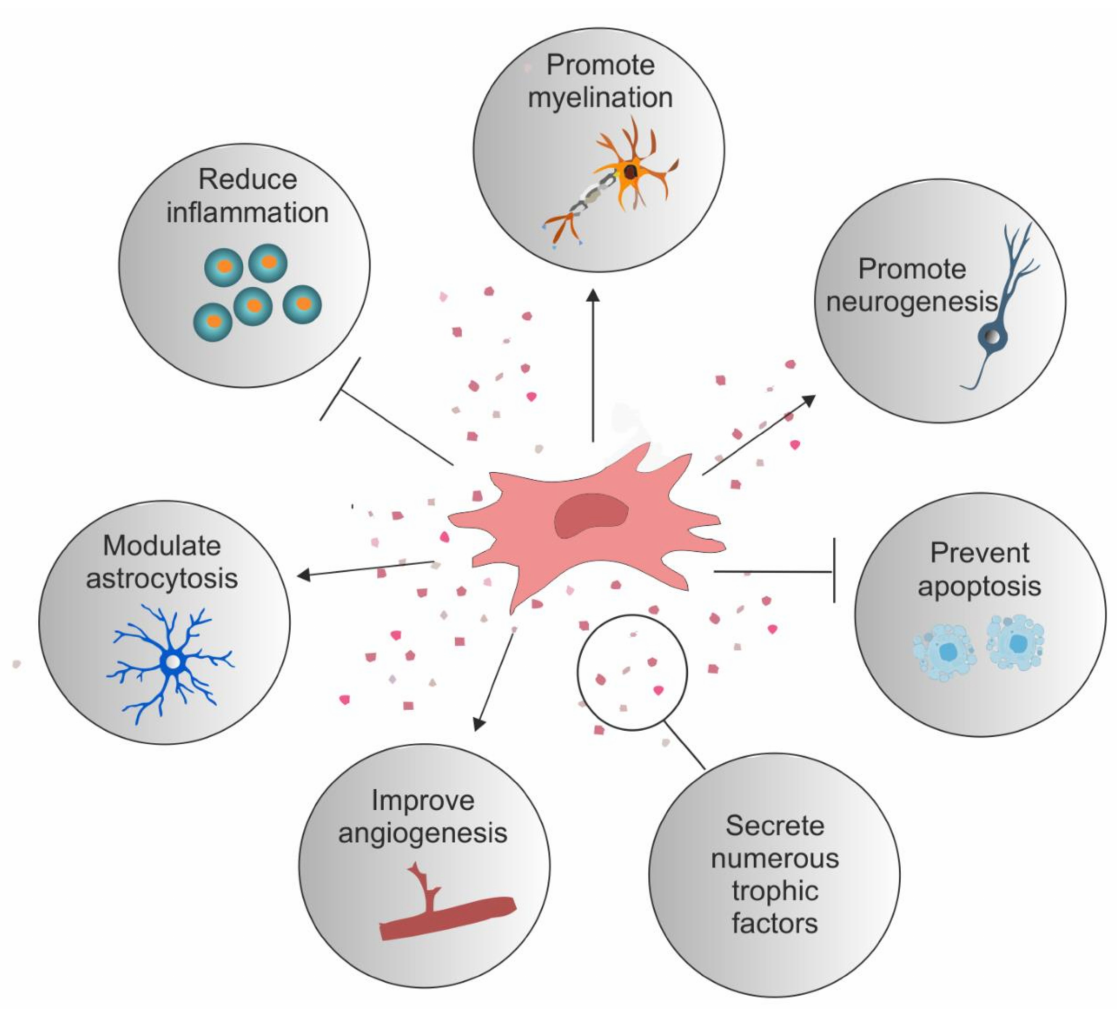
Figure 1. Reparative role of mesenchymal stromal cells. Examples of the reparative potential of mesenchymal stromal cells (MSCs) for spinal cord injury (SCI). MSCs secrete numerous trophic factors and anti-inflammatory molecules that change the injury milieu to pro-regenerative. These secreted factors have an anti-inflammatory effect on numerous immune cells such as T cells, B cells, macrophages, and microglia. They reduce astrocytosis and promote axonal growth and neuroprotection. They stimulate angiogenesis and offer protection against apoptotic cell death. Certain MSC types promote the differentiation of oligodendrocytes and